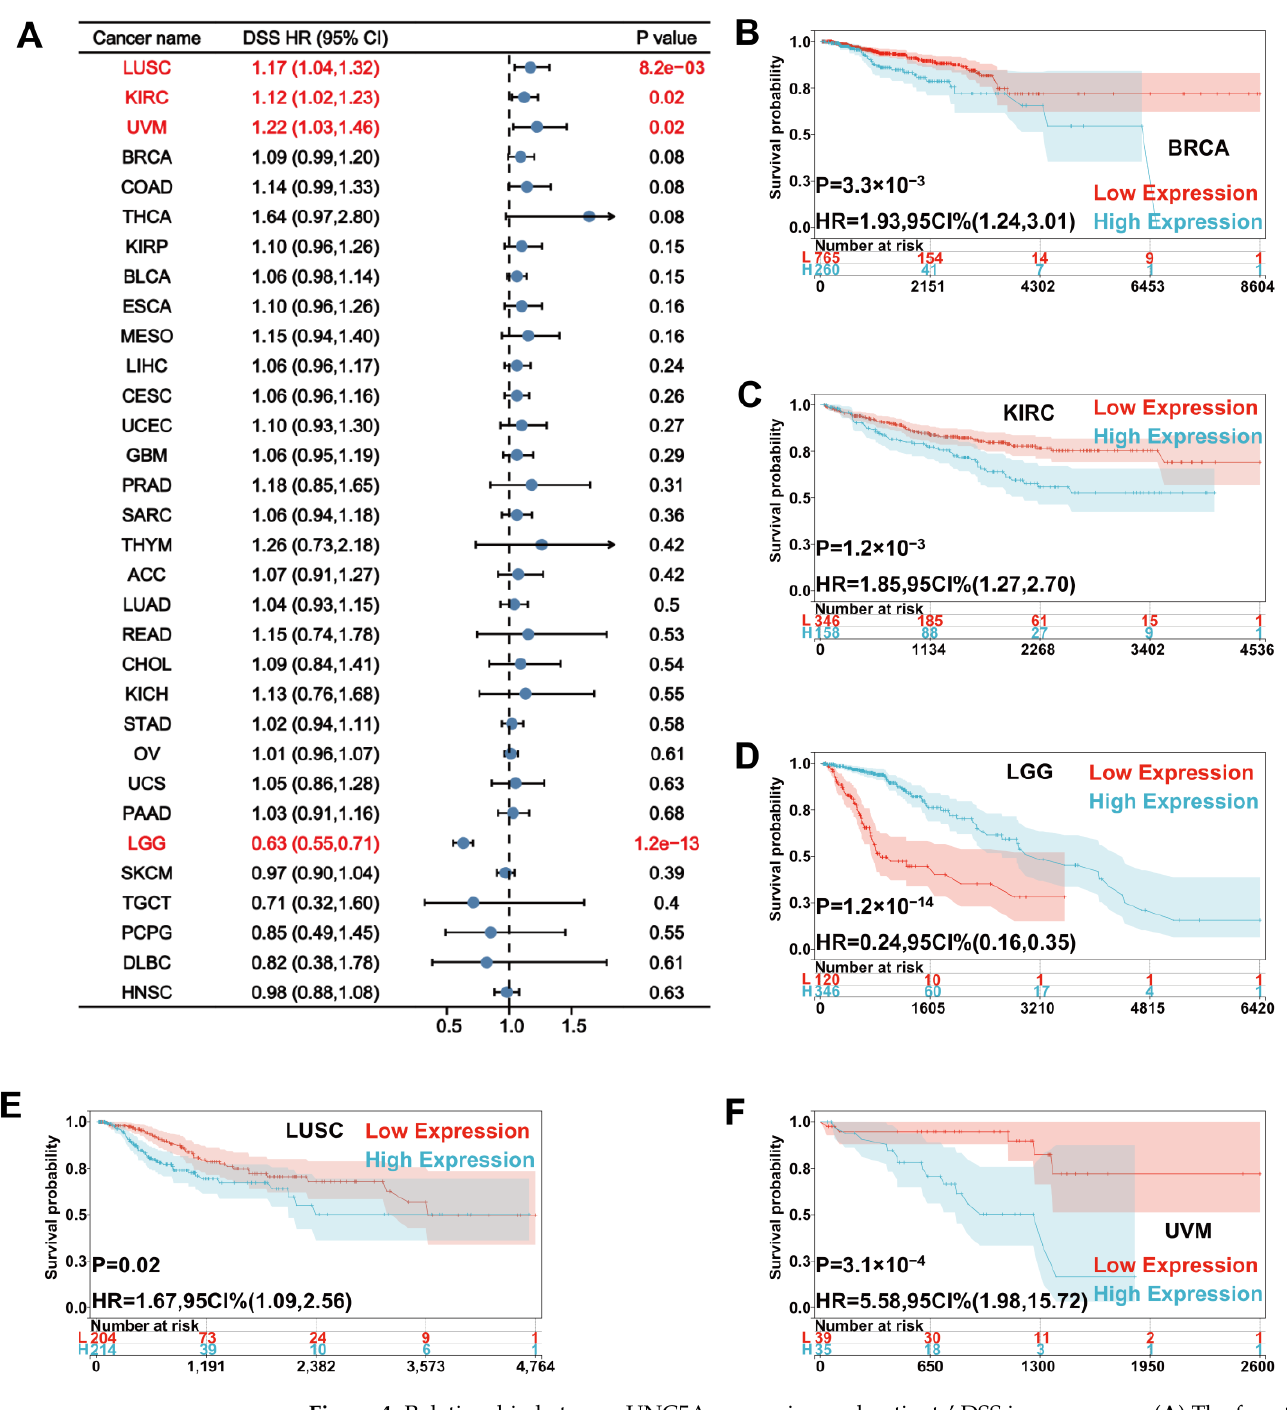
Figure 4. Relationship between UNC5A expression and patients’ DSS in pan-cancer. ( A ) The forest plot shows the relationship between UNC5A expression and DSS in pan-cancer. ( B – F ) Kaplan-Meier analysis shows the association between UNC5A expression and DSS in pan-cancer.